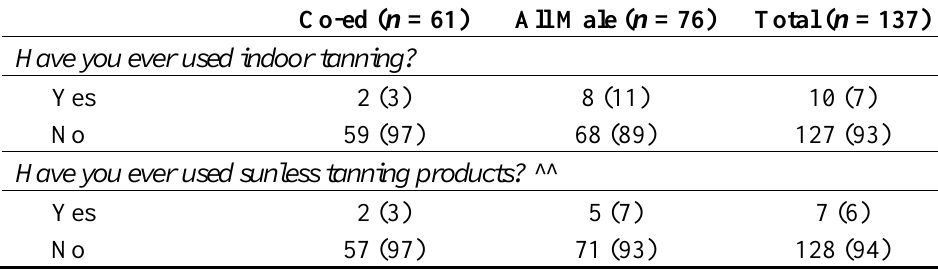
Table 5. Comparison of tanning behaviors.